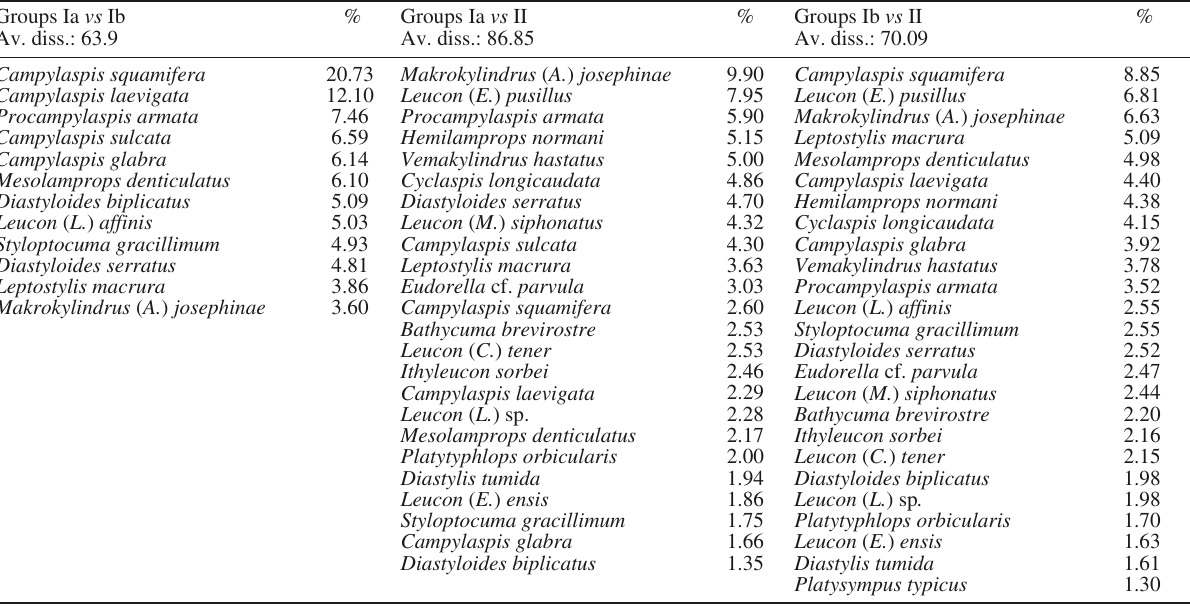
Fig. 3. – Hierarchical cluster analysis (A) and non-metric multidi- mensional scaling (B) of the 12 slope stations (TS09 excluded; see text) based on square-root transformed abundances and Bray-Curtis similarity Table 5. – Average dissimilarity between the 3 main station groups discriminated by the multivariate analysis of the 12 sampling stations (sta- tion TS02 discarded) and contribution of cumacean species to total dissimilarity. A cut-off at a cumulative dissimilarity of 85% was applied. Av. diss., average dissimilarity.